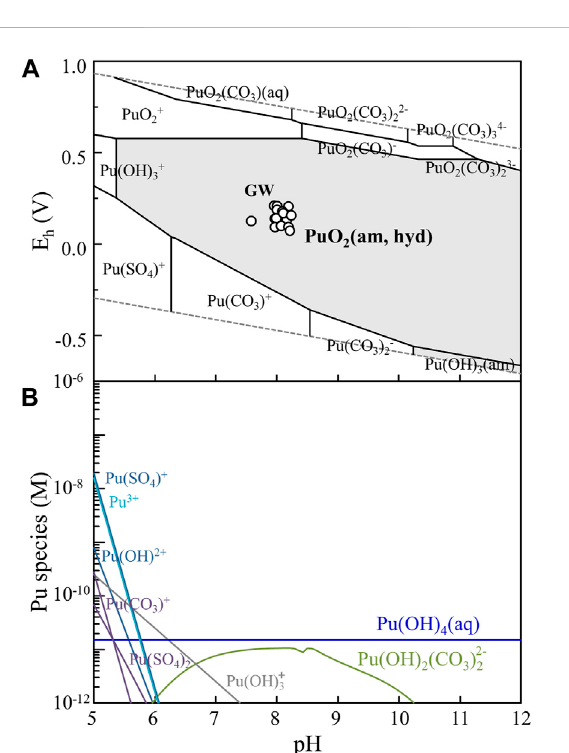
FIGURE 4 (A) Pourbaix diagram of Pu ([Pu] = 10 − 10 M) was a result of geochemical modeling at the GW1F condition (set A) and displayed with the measured E h and pH values of GW ( ○ ) listed in Table 2 and Supplementary Table S3. The dashed lines indicate the boundaries of water stability: upper and lower limits for the oxidation and reduction of water, respectively. (B) Species distribution at [Pu] of 10 − 6 M in the GW1F sample shows that low concentrations